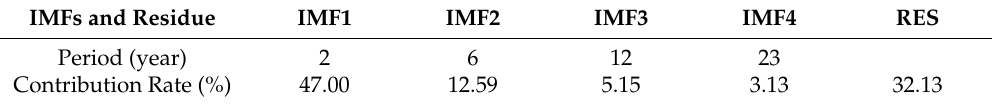
Table 2. Each IMF cycle and its variance contribution rate for precipitation in